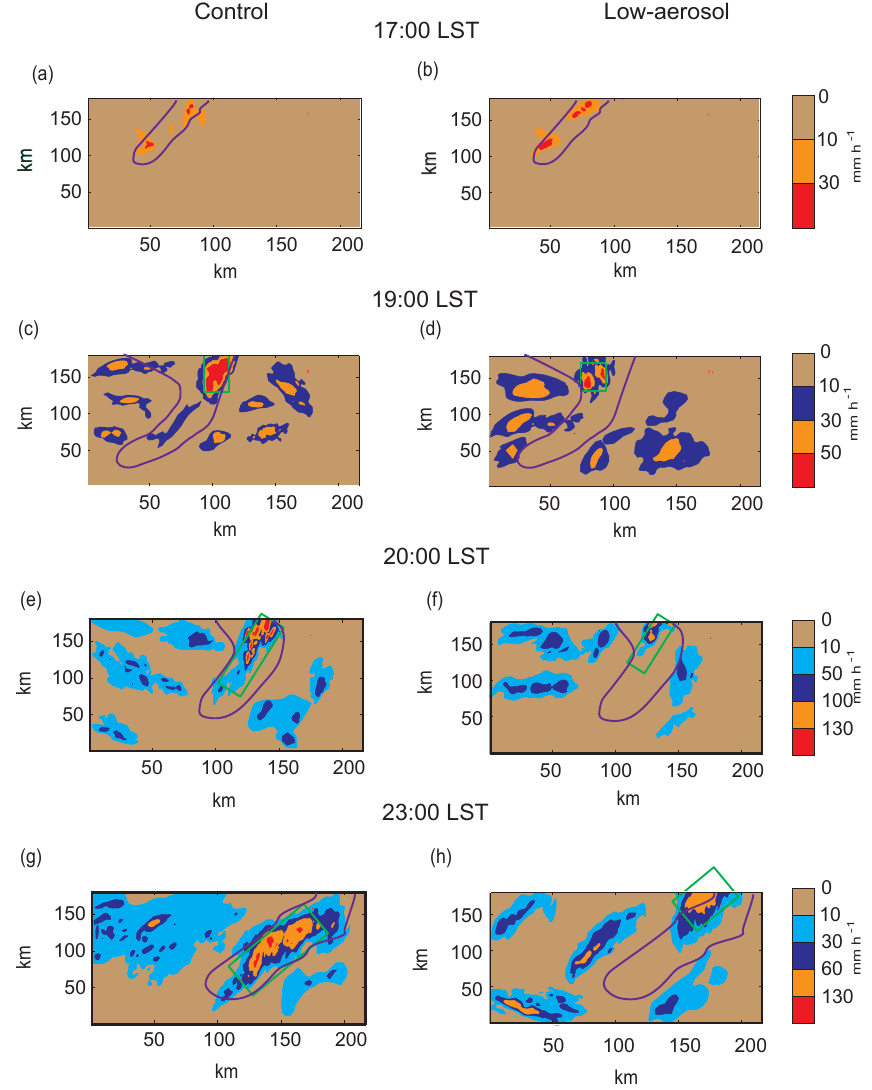
Figure 8. Spatial distributions of precipitation rates at the surface. Green rectangles mark areas with heavy precipitation and are described in detail in text. Purple lines mark the eastern part of where there is substantial transition from high-value aerosol concentrations to low-value aerosol concentrations as in Fig. 4. Panels (a) , (c) , (e) , and (g) are for the control run, while panels (b) , (d) , (f) , and (h) are for the low-aerosol run. Panels (a) and (b) are for 17:00LST, and panels (c) and (d) are for 19:00LST. Panels (e) and (f) are for 20:00LST, and panels (g) and (h) are for